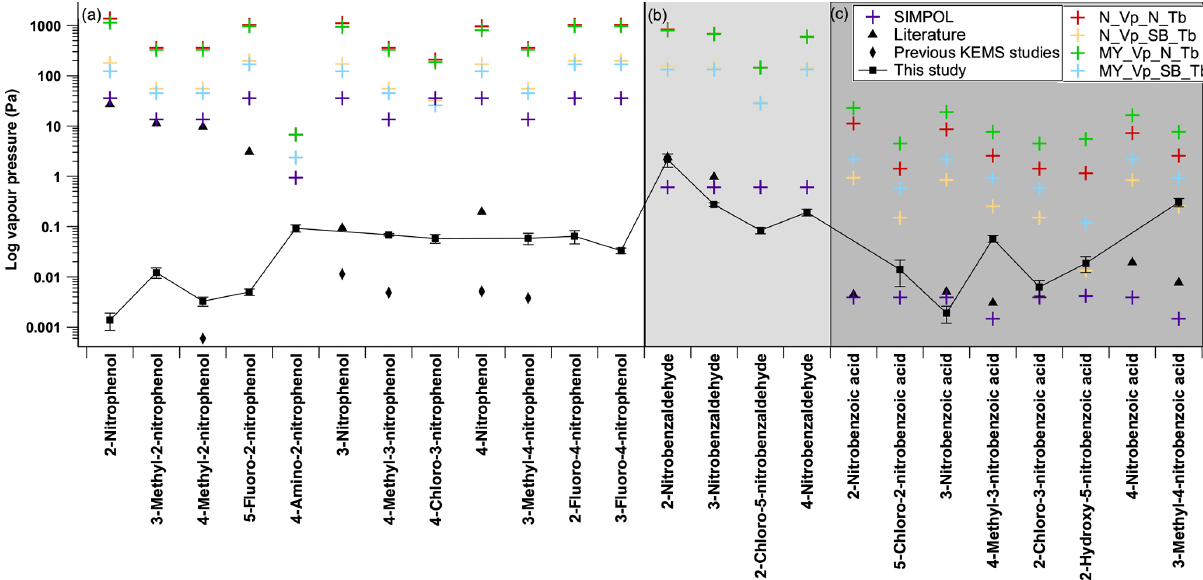
Figure 10. Comparison of estimated and measured subcooled saturation vapour pressures. N_Vp (Nannoolal vapour pressure), MY_Vp (Myrdal and Yalkowsky vapour pressure), SIMPOL (SIMPOL vapour pressure), N_Tb (Nannoolal boiling point), SB_Tb (Stein and Brown boiling point), literature – black triangle (2-nitrophenol, 3-methyl-2-nitrophenol, 4-methyl-2-nitrophenol, 5-fluoro-2-nitrophenol and 4- nitrophenol from Schwarzenbach et al., 1988; 3-nitrophenol from Ribeiro da Silva et al., 1992; 2-nitrobenzaldehyde and 3-nitrobenzaldehyde from Perry et al., 1984; 2-nitrobenzoic acid, 3-nitrobenzoic acid and 4-nitrobenzoic acid from Ribeiro Da Silva et al., 1999; 4-methyl-3- nitrobenzoic acid and 3-methyl-4-nitrobenzoic acid from Monte et al., 2001), and literature data for previous KEMS studies – black diamond (3-nitrophenol and 4-nitrophenol from Bannan et al., 2017; 4-methyl-2-nitrophenol, 4-methyl-3-nitrophenol and 3-methyl-4-nitrophenol from Dang et al., 2019). Error bars on the experimental data points are ± 1 standard deviation. Panel (a) contains nitrophenols, panel (b) contains nitrobenzaldehydes and panel (c) contains nitrobenzoic acids. Table 8. Average difference between the experimental P sat and the predicted P sat . N_Vp is the Nannoolal et al. vapour pressure method L L (Nannoolal et al., 2008), MY_Vp is the Myrdal and Yalkowsky vapour pressure method (Myrdal and Yalkowsky, 1997), N_Tb is the Nan- noolal et al. boiling point method (Nannoolal et al., 2004), and SB_Tb is the Stein and Brown boiling point method (Stein and Brown,